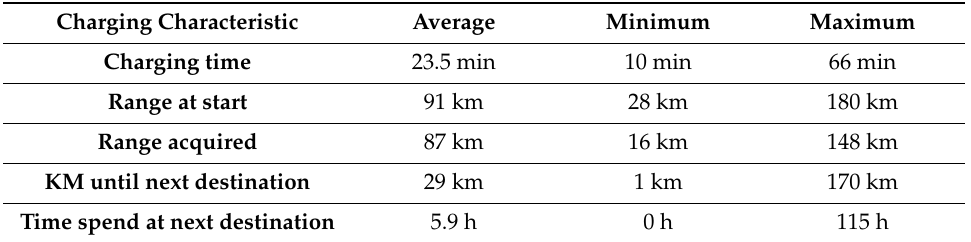
Table 2. General information of survey results.